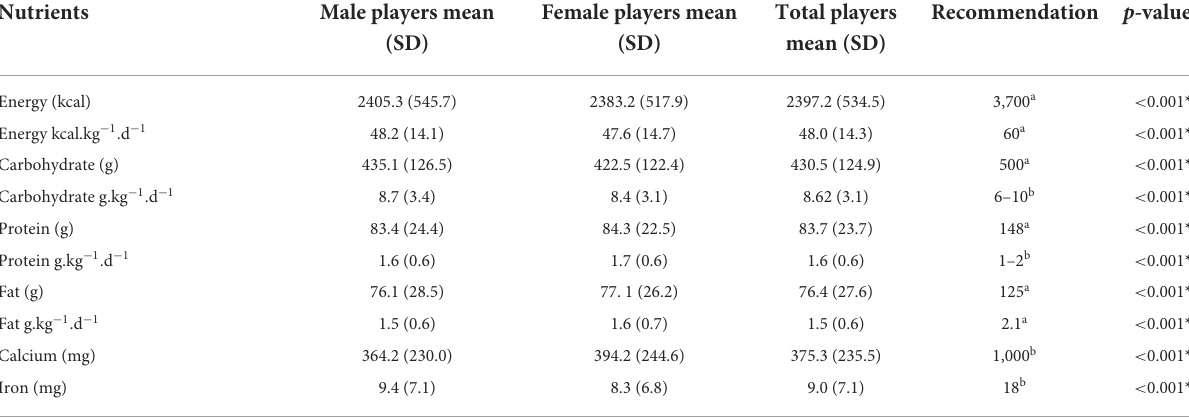
TABLE 4 Description of daily nutrient intake per day compared to corresponding RDA of Taekwondo players ( n = 293). Nutrients